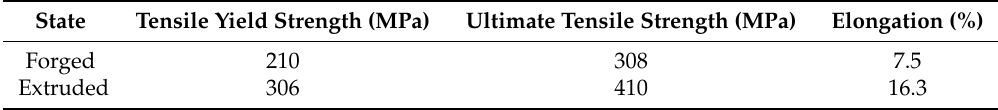
Figure 2. The distribution of grain size in the forged alloy and extruded alloy analyzed by electron Table 1. Tensile mechanical properties of the forged alloy and extruded alloy.